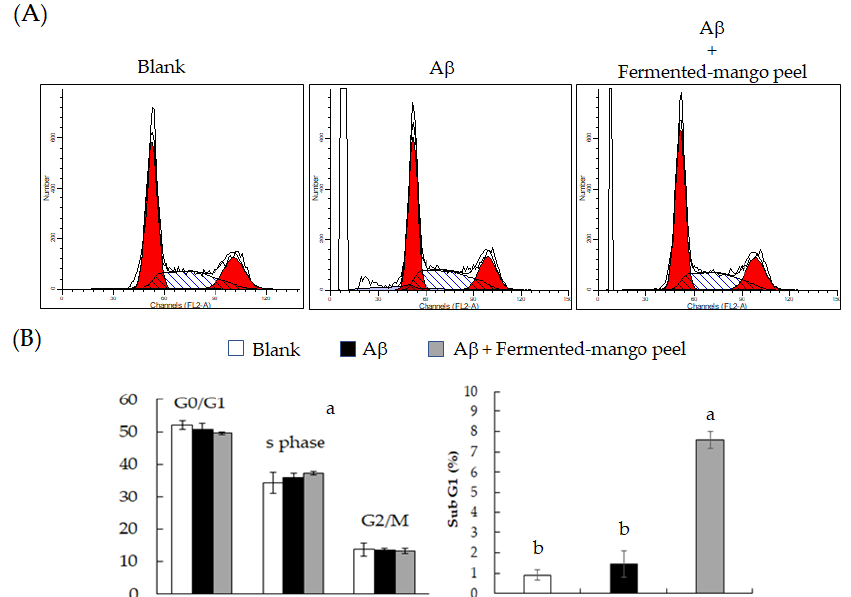
Figure 7. The levels of cell cycle and subG1 in Neuron-2A cells treated by A β with or without L.